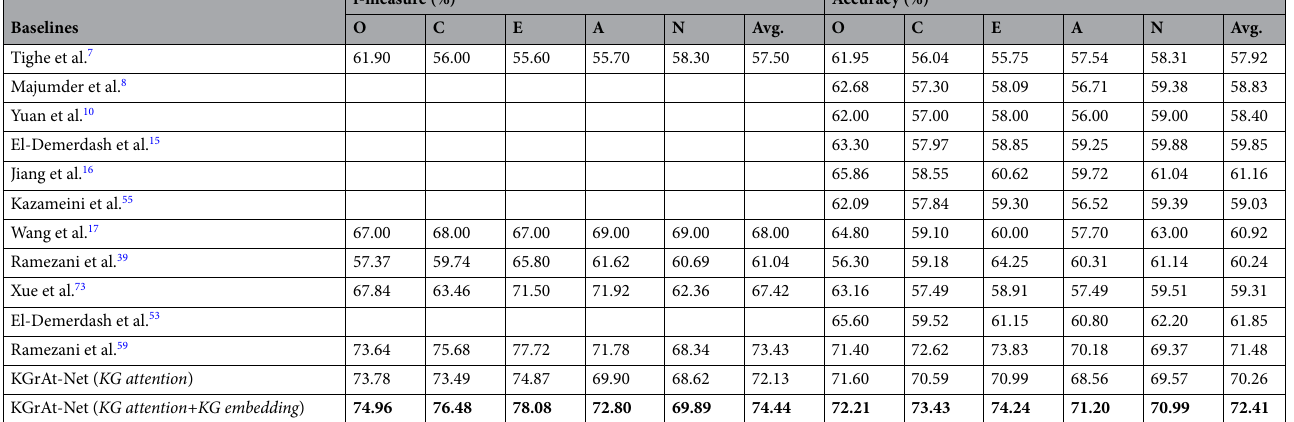
Table 5. Comparing the performance of baseline models in APP from text, which were performed on Essays Dataset (missing values are not reported). Significant values are in